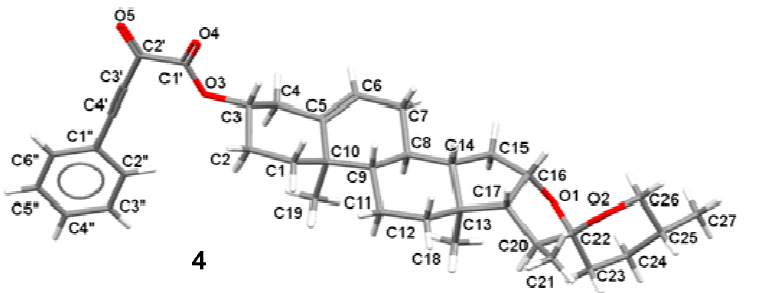
Scheme 2. Synthesis of steroidal ynediones 4 – 8 from diosgenin 1 .